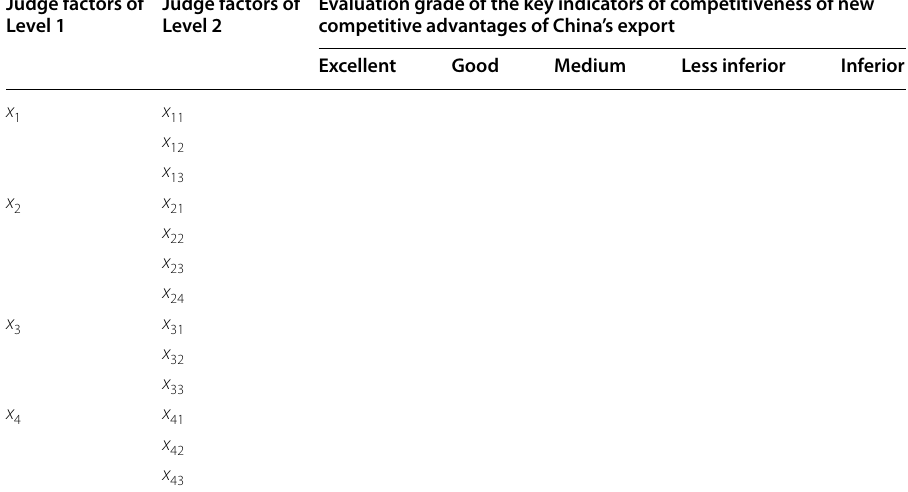
Table 1 Key indicator evaluation of the new competitive advantages of China’s export (the n th